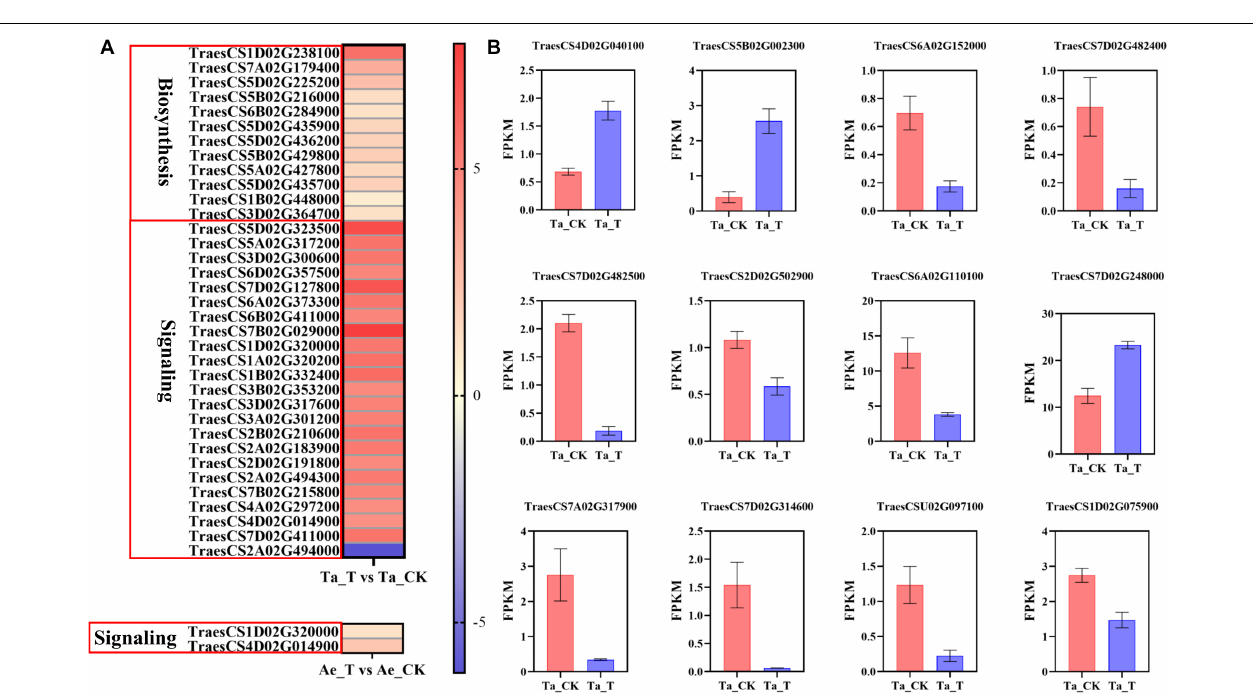
FIGURE 4 | (A) The expression level of DEGs related with auxin biosynthesis and signal transduction in T. aestivum and Ae. tauschii based on log 2 (fold change) with untreated plants as control. DEGs related with auxin signal transduction in T. aestivum with | log 2 (fold change)| over 4 are shown. Each row represents one gene. (B) The fragments per kilobase of exon model per million mapped reads (FPKM) values of DEGs associated with tiller bud development in T. aestivum . Error bars represent the mean ± SD ( n = 3). Other abbreviations were as shown in Figure 2 .